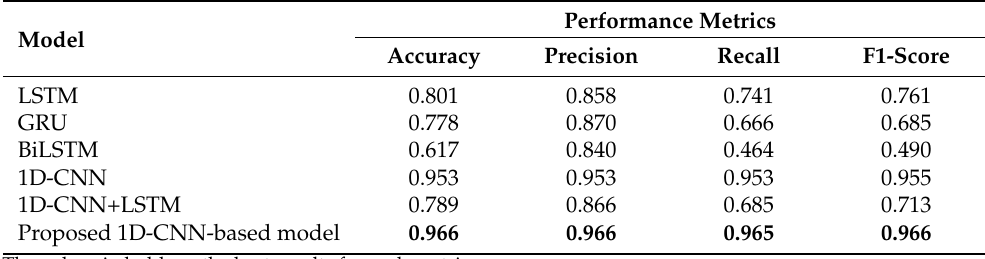
Table 7. Performance comparison of the proposed model with different baselines.